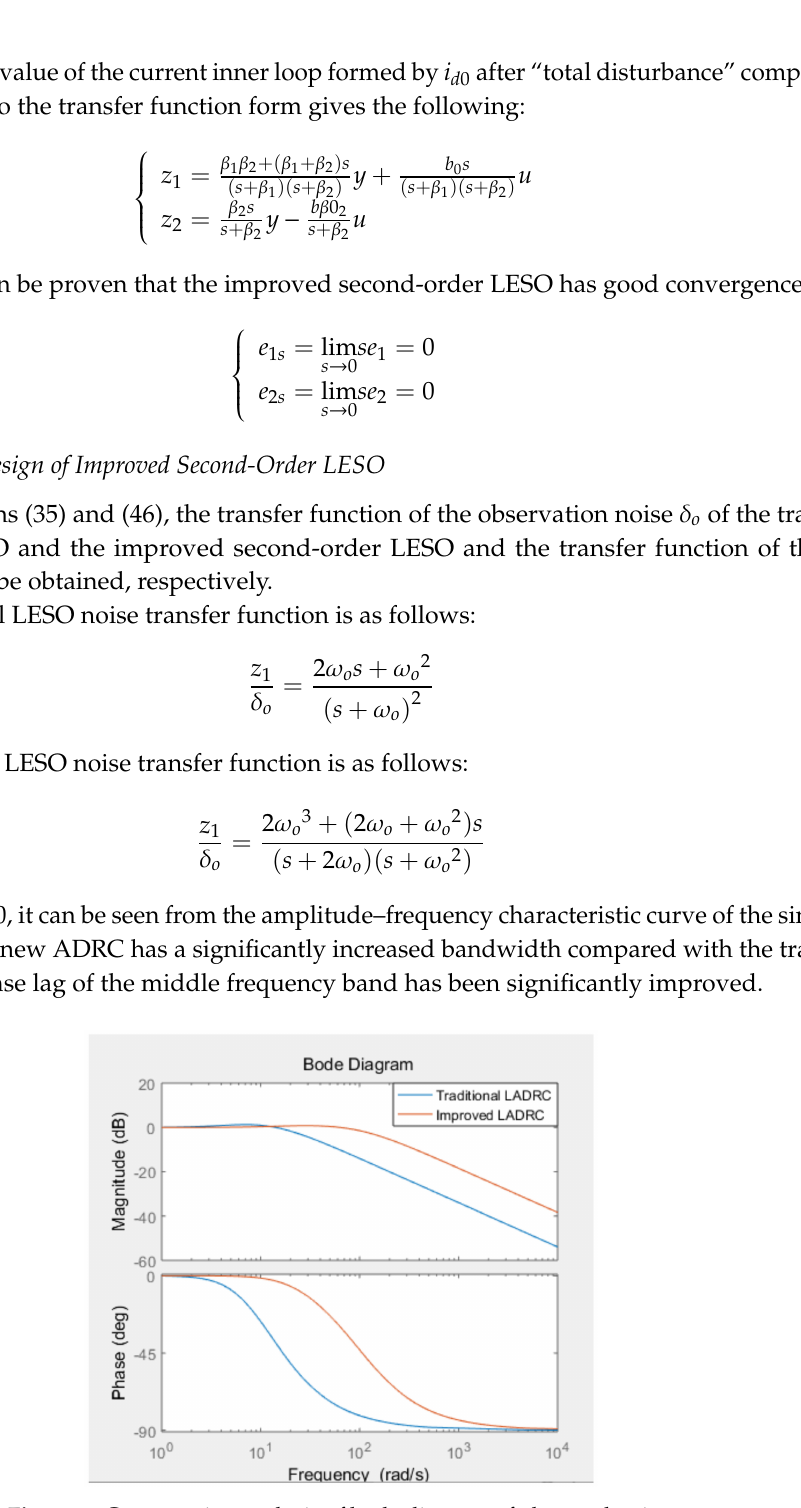
Figure 8. Comparative analysis of bode diagram of observed